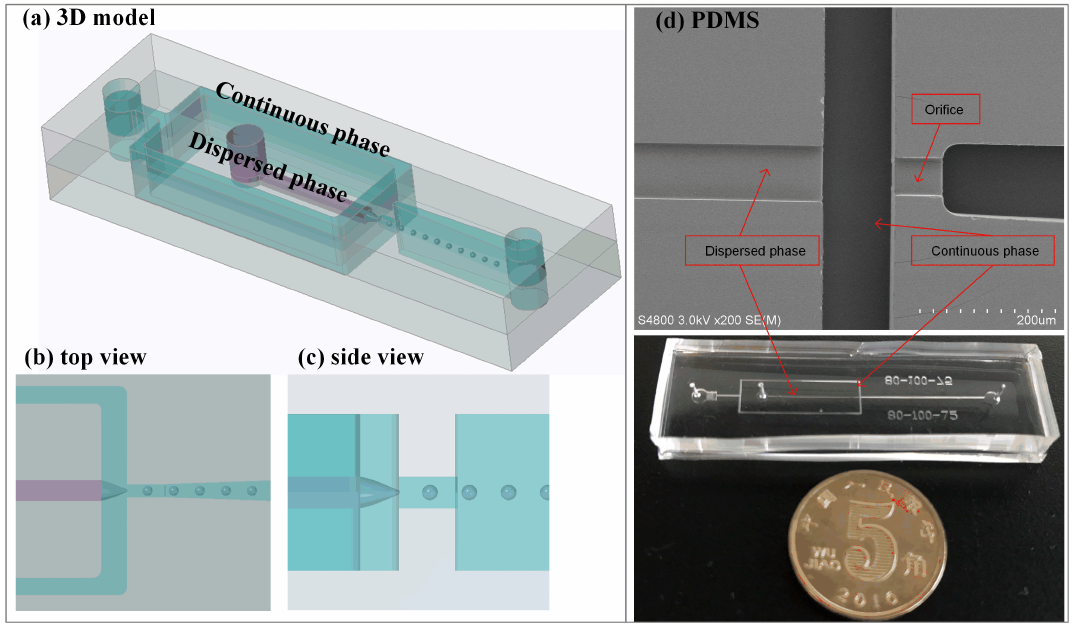
Figure 1. A semi-3D flow-focusing microfluidic device. ( a ) Schematic diagram of 3D model. ( b , c ) Top view and side view. ( d ) Structures of PDMS slab under SEM and monolithic microfluidic